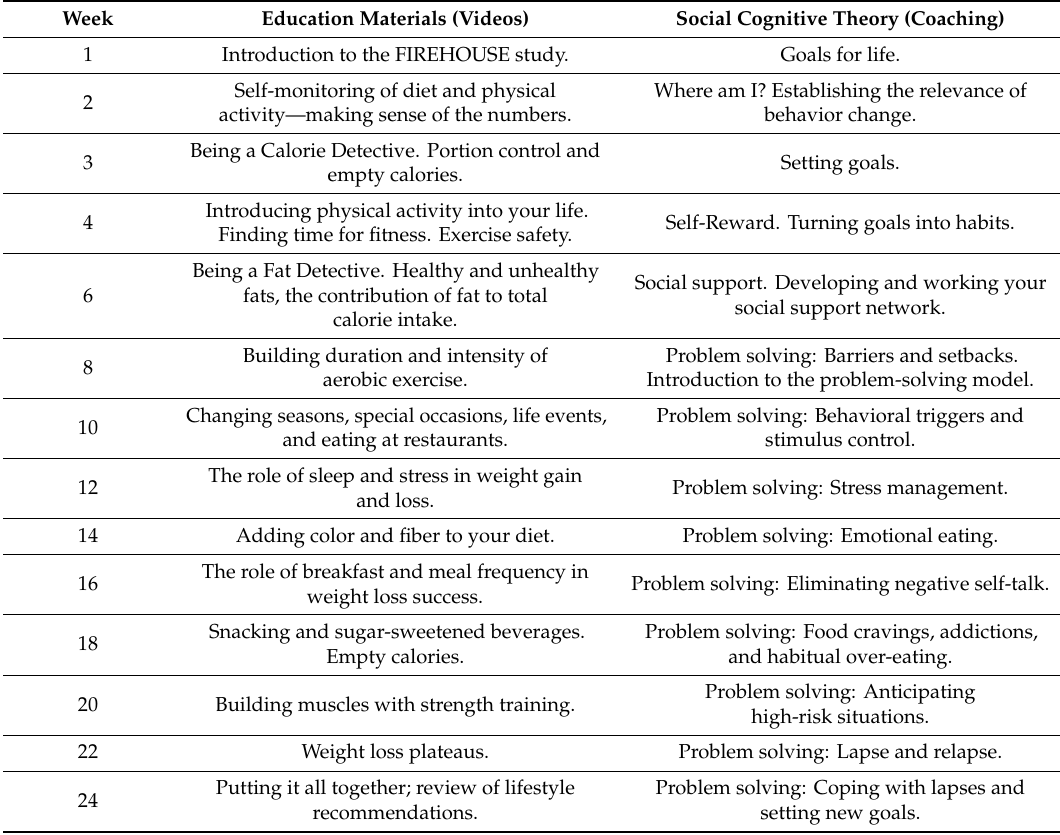
Table 3. Intervention Behavioral Component